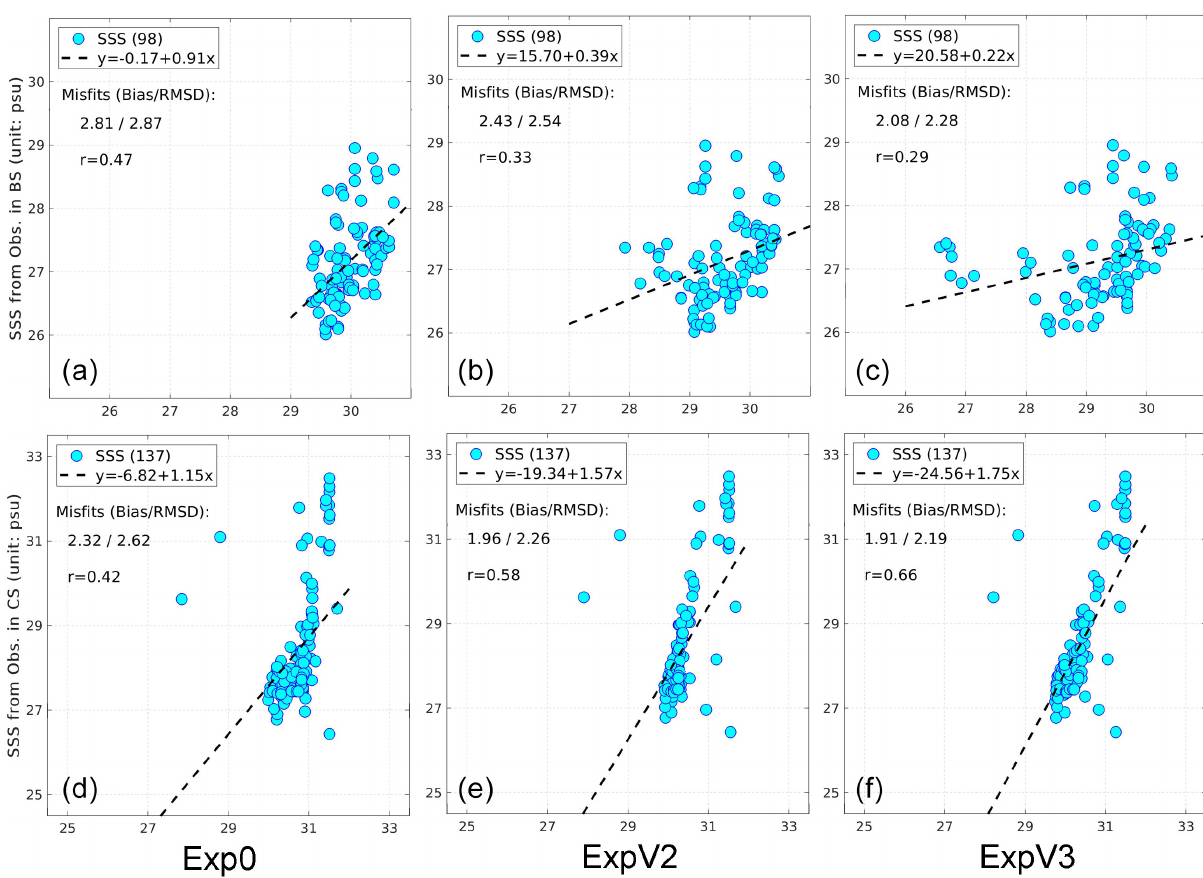
Figure 7. Scatterplots of SSS (unit: psu) in the three assimilation runs Exp0, ExpV2, and ExpV3 against the CTD observations collected by different cruises in 2016. (a–c) Beaufort Sea; (d–f) Chukchi Sea, as shown in Fig. 1. All the correlation coefficients are over the 95% signif- icance